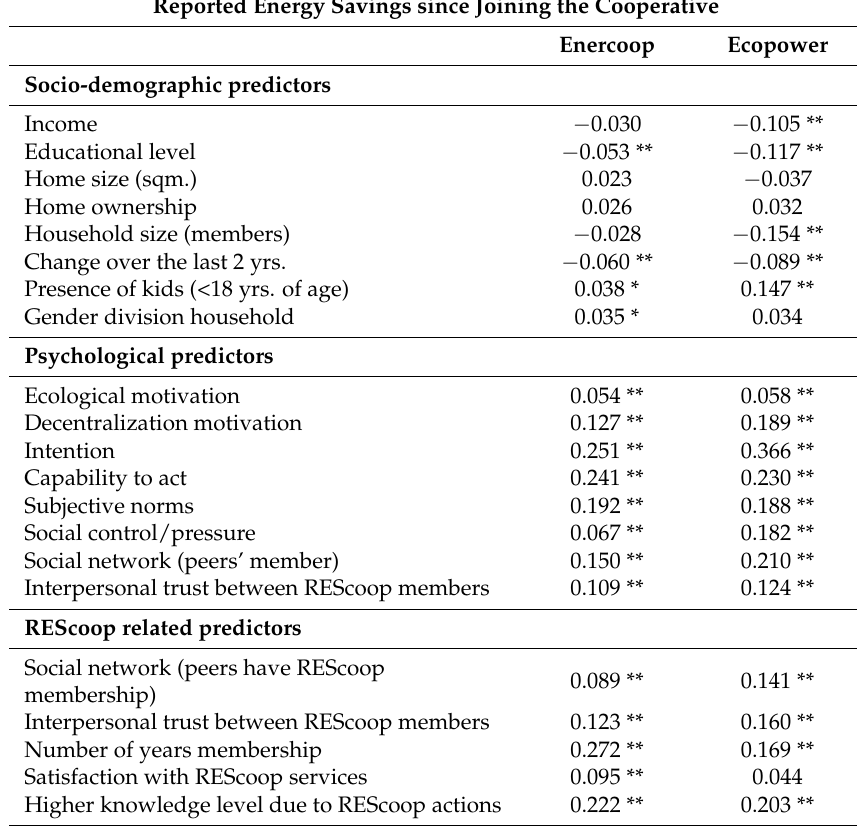
Table 7. Correlations for selected predictors and reported energy